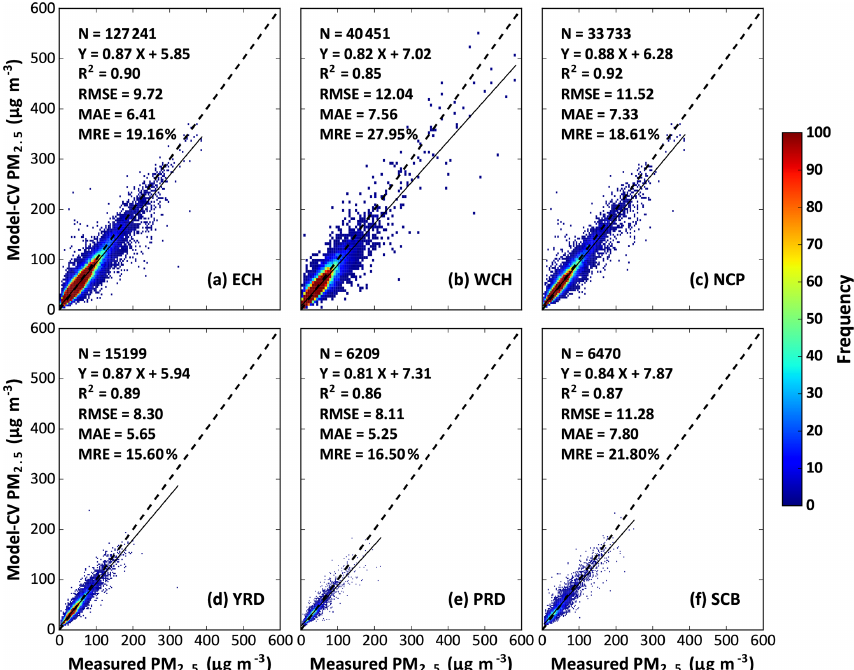
Figure 6. Density scatter plots of out-of-sample 10-CV results for (a) eastern China (ECH), (b) western China (WCH), (c) the North China Plain (NCP), (d) the Yangtze River Delta (YRD), (e) the Pearl River Delta (PRD) and (f) the Sichuan Basin (SCB) in 2018. Statistical metrics are given in each panel, along with the linear regression relation, including the number of samples ( N ), the correlation of determination ( R 2 ), the root-mean-square error (RMSE), the mean absolute error (MAE) and the mean relative error